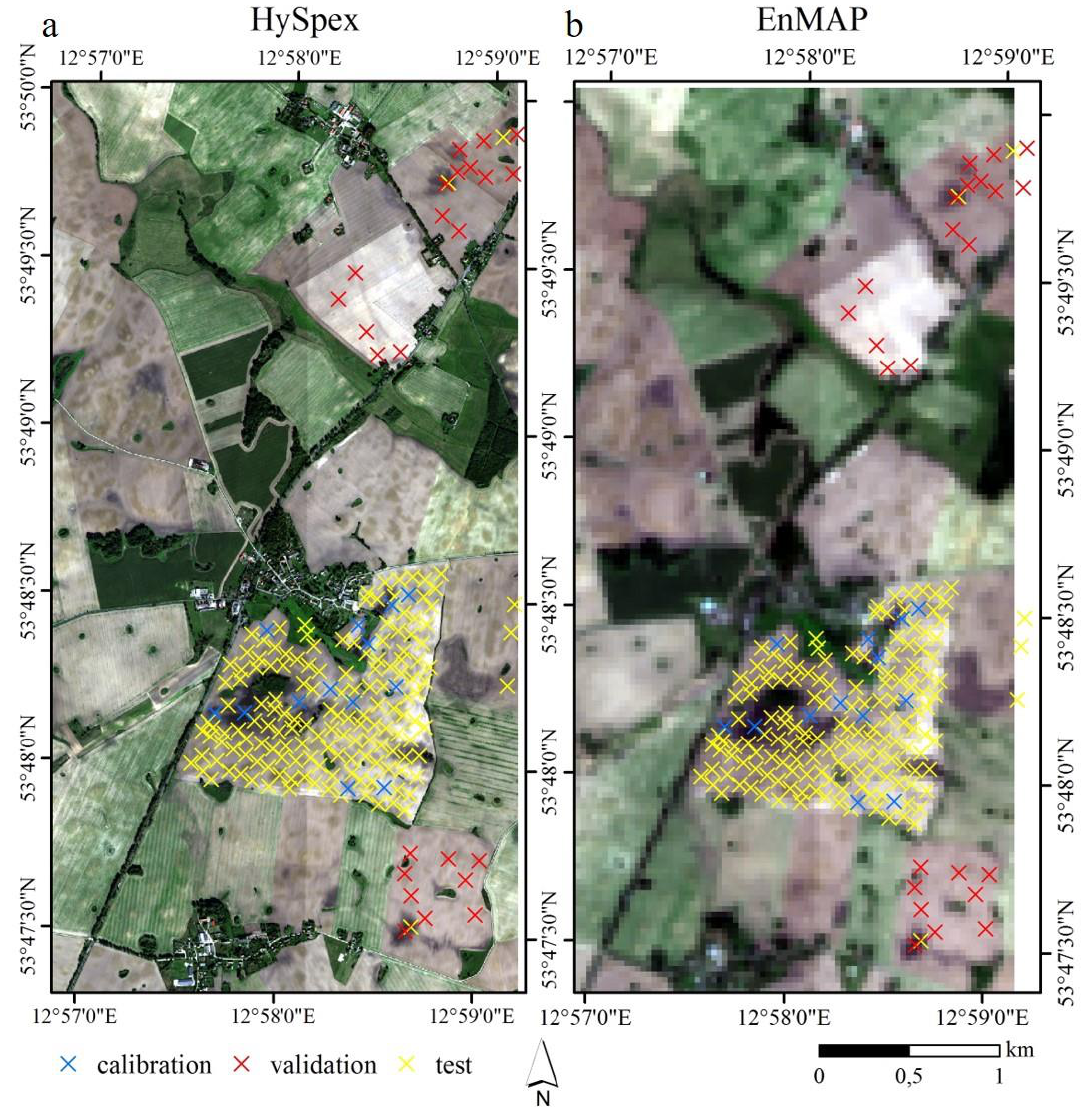
Figure 4. HySpex ( a ) and simulated EnMAP ( b ) images of the study sites as RGB composites. Locations of soil samples for model calibration (blue), validation (red) and test (yellow) are shown as